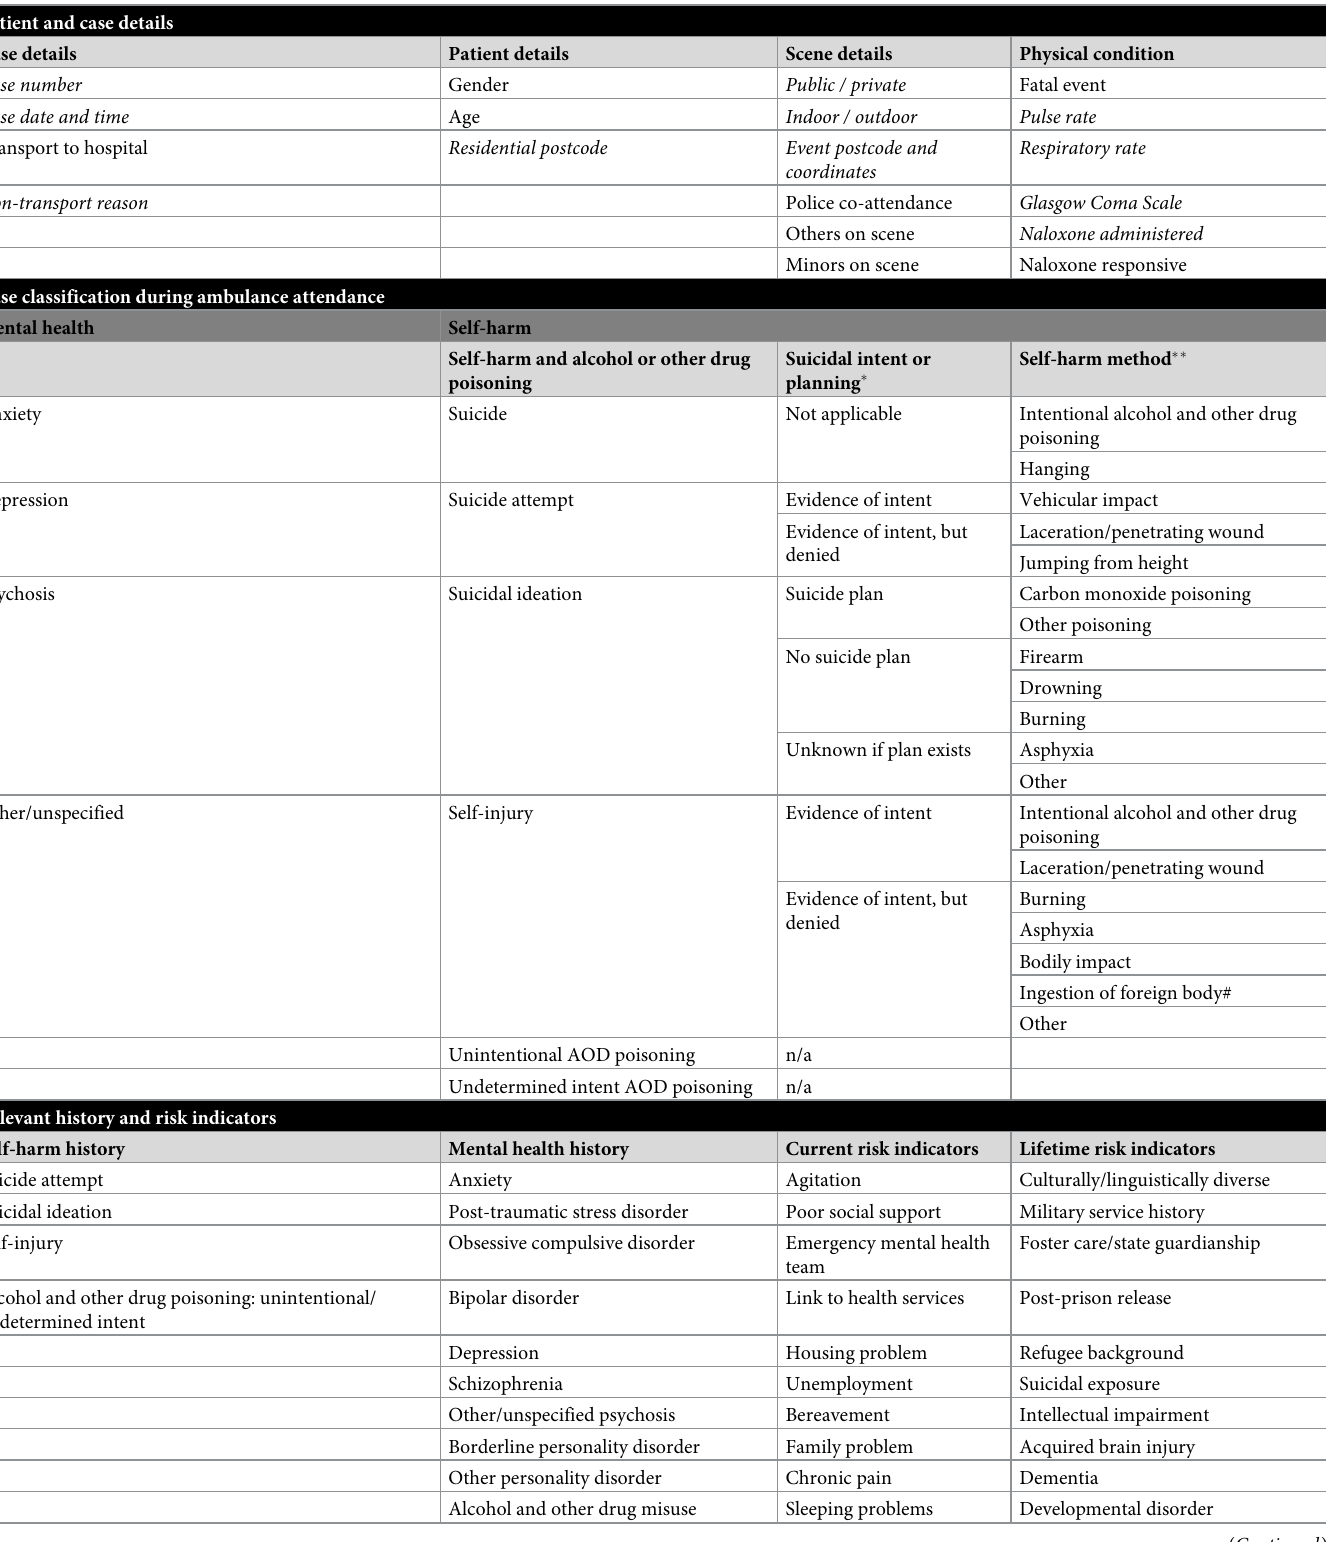
Table 1. Self-harm and mental health variables available in the NASS